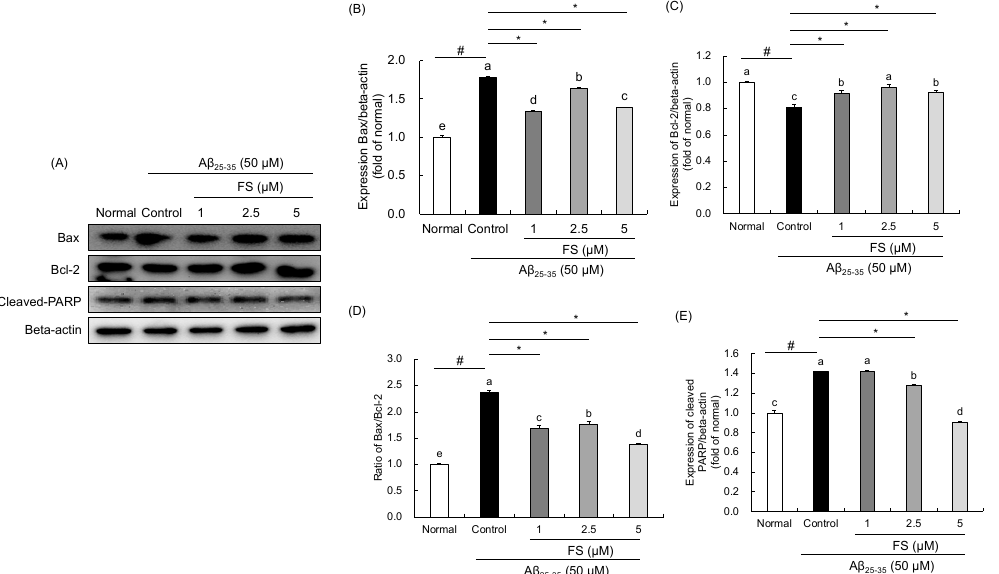
Figure 5. Effects of N -feruloyl serotonin on expressions of Bax, Bcl-2, and cleaved PARP in SH-SY5Y cells. The western blot bands ( A ), relative protein levels of Bax ( B ), Bcl-2 ( C ), ratio of Bax and Bcl-2 ( D ), and cleaved PARP ( E ). Values present means ± SD ( n = 3). a–e Means with different letters are significantly different ( p < 0.05) by Duncan’s multiple range test. # p < 0.01 vs. normal; * p < 0.05 vs. control. FS, N -feruloyl serotonin.